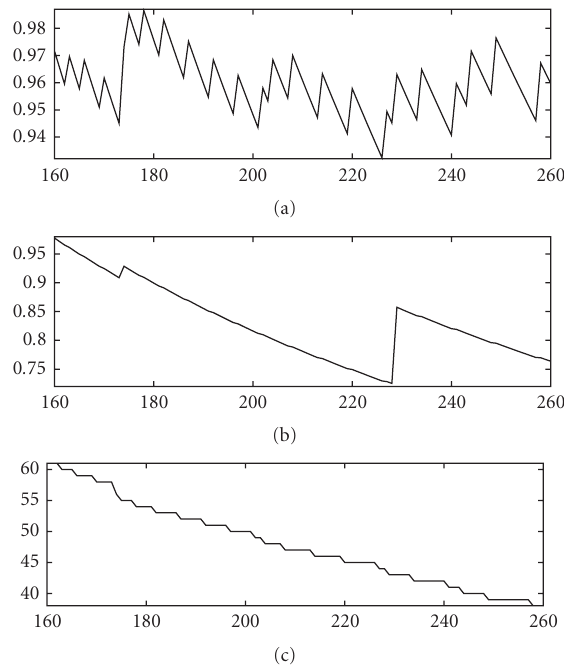
Figure 4: Configurations as a function of f i with single clock domain: (a) total utilization, (b) total delay in millisecond, (c) the number of processors. The x -axis denotes f i in